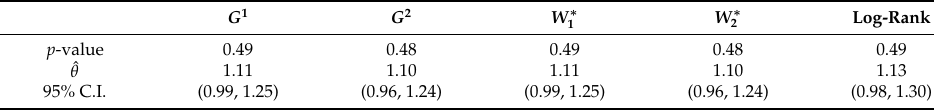
Figure 4. Estimated cumulative hazard functions, vaginal cancer. Table 4. Point estimates and p − values, vaginal